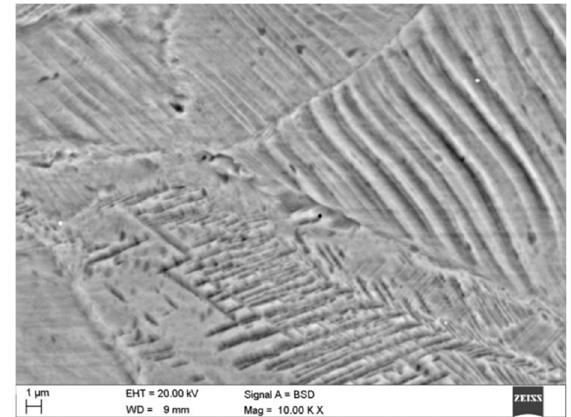
Figure 17. SEM image of the austenitic microstructure of 16Mn–3Si–3Al cold-worked TWIP steel showing slip bands and deformation twins